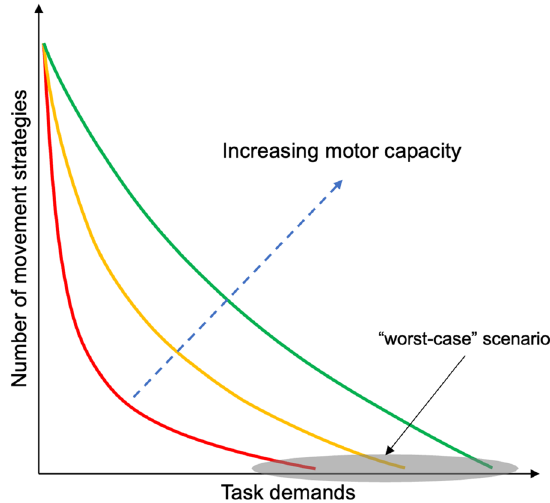
Fig. 3 The theoretical relationship between task demands and the number of possible movement strategies with increasing motor